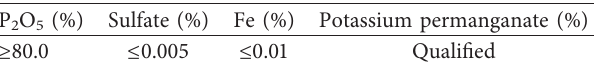
Table 2: Main parameters of